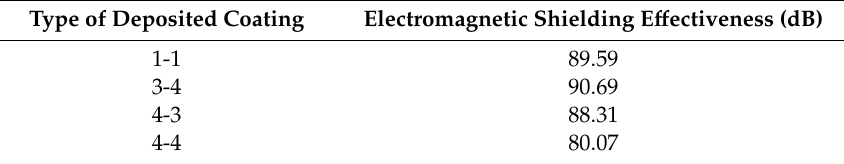
Figure 7. Electromagnetic shielding curve. Table 10. Relation between the number of deposition and electromagnetic shielding e ff ectiveness (300 KHz to 2.0